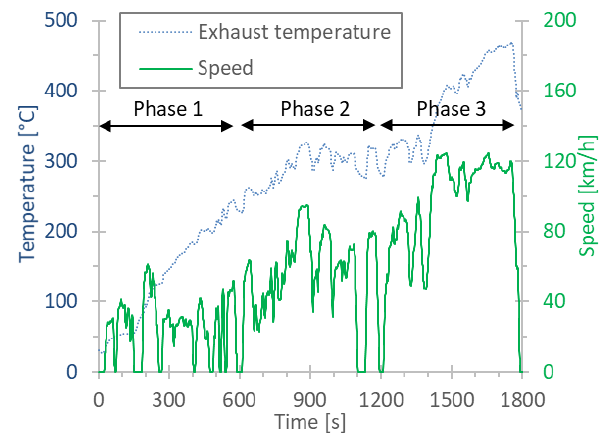
Fig. 2. Speed profile and exhaust gas temperature at the tailpipe Figure 5 plots the particle number (PN) signals as measured from the dilution